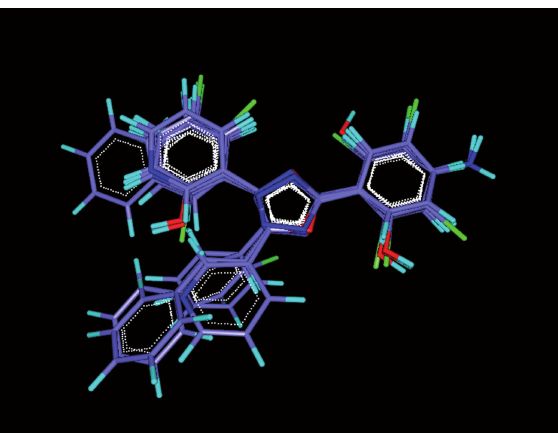
F 3: Aligned molecule (stick